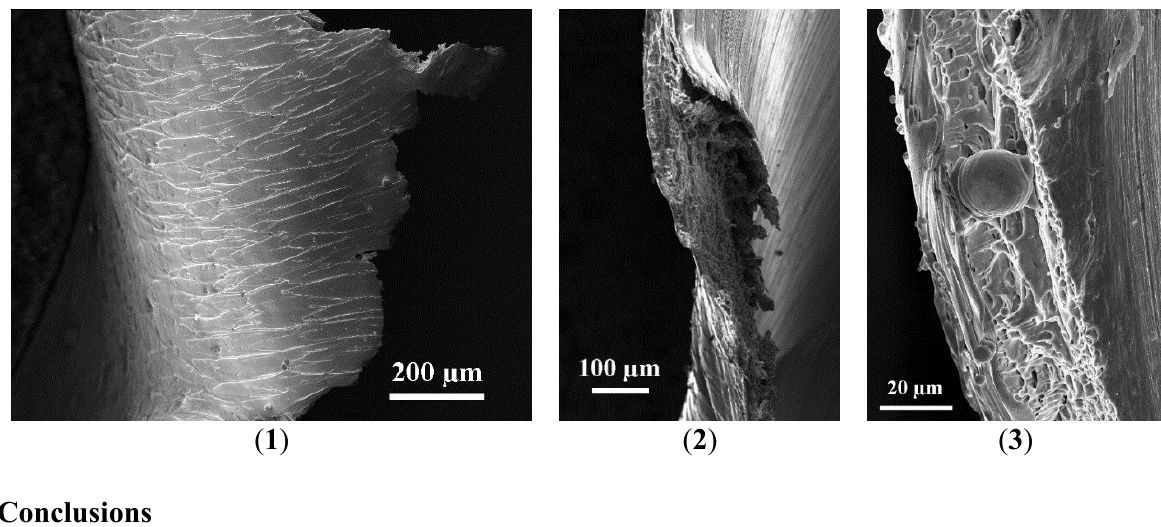
Figure 14. Scanning electron micrographs of an Fe sample recovered after a 255 GPa laser shock, consistent with the scenario depicted in Figure 13: signs of extensive melting on the loaded side ( 1 ); edge of the spall crater indicative of strain and fracture in the solid state ( 2 ); relatively large molten volumes still attached to the sample ( 3